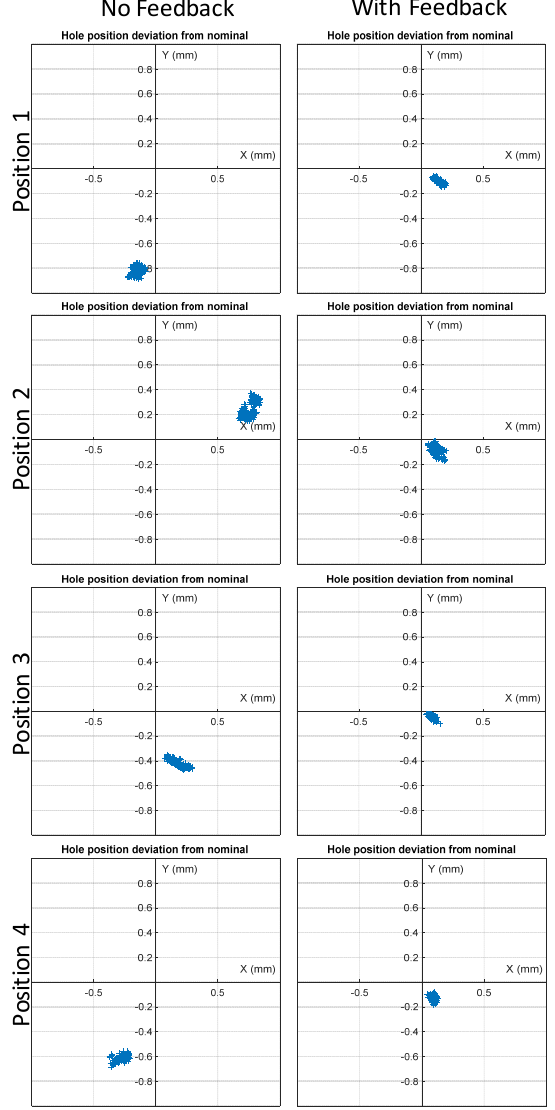
Figure 22. Best-fit hole center absolute position errors for all positions. J. Manuf. Mater. Process. 2020 , 4 , x FOR PEER REVIEW